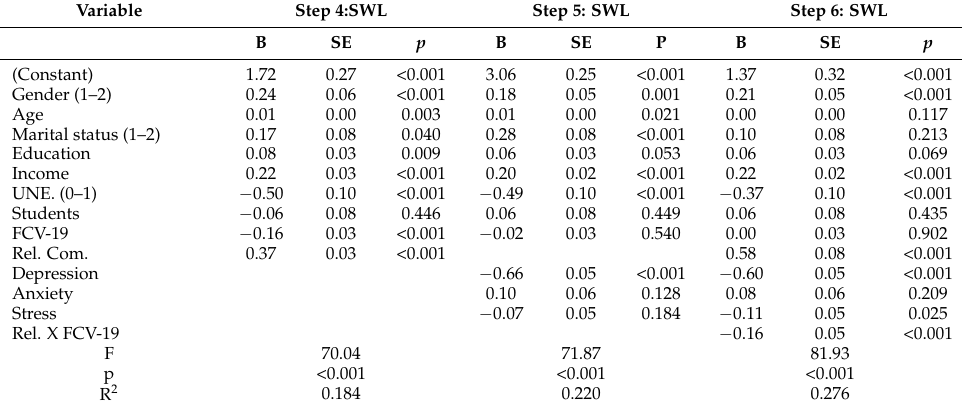
Table 4. Main effects on satisfaction with life. Variable Step 4:SWL Step 5: